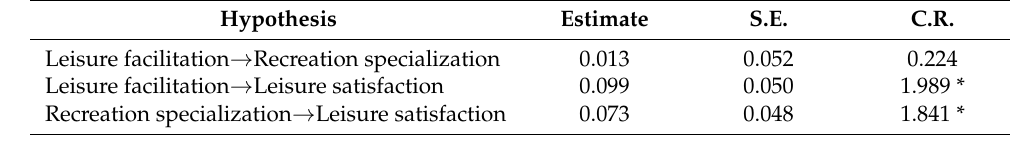
Table 5. Estimated structural relations